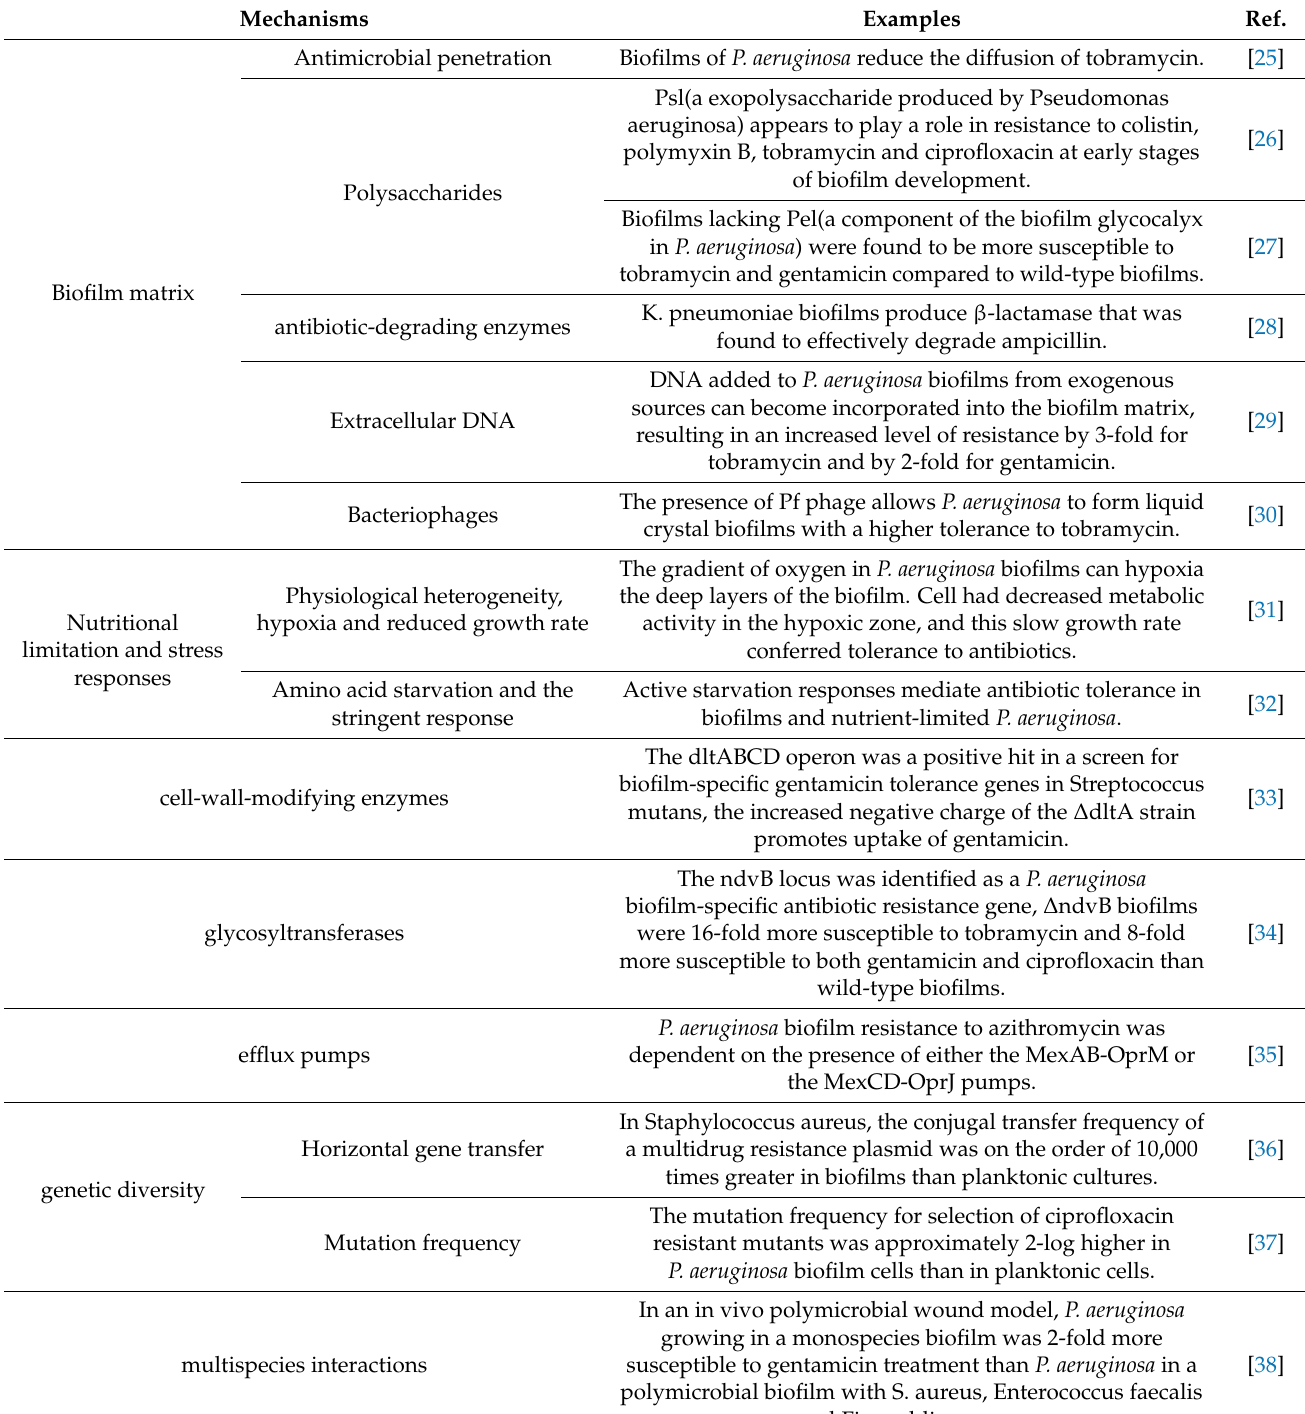
Table 1. Mechanisms of biofilm-based antibiotic resistance and tolerance in pathogenic